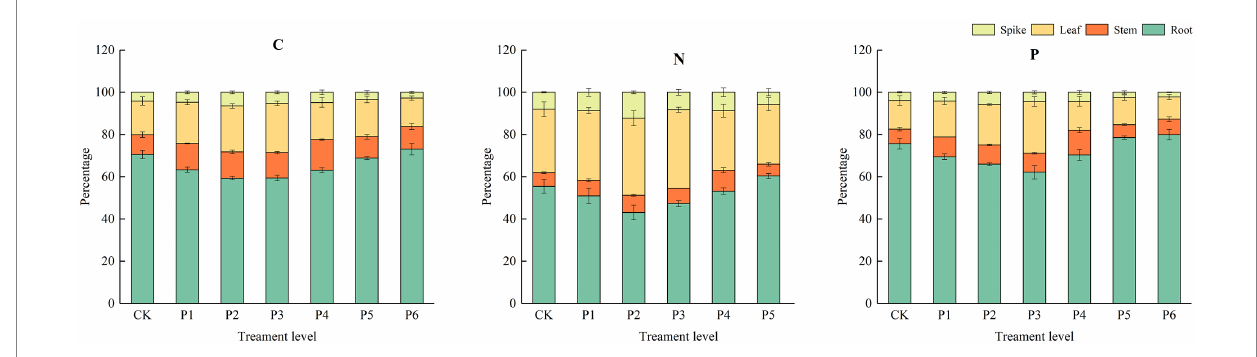
FIGURE 3 The effect of P fertilizer gradients on the distribution of C, N, and P contents in different organs at the different growth stages of